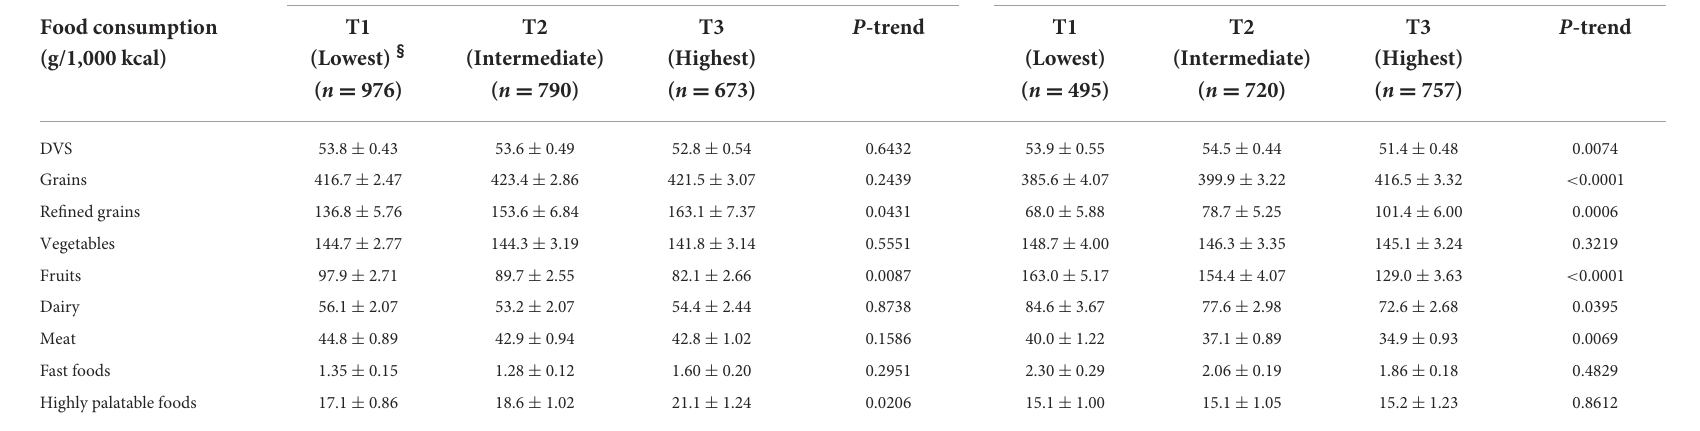
TABLE 2 Food consumption according to stress levels. Men Women